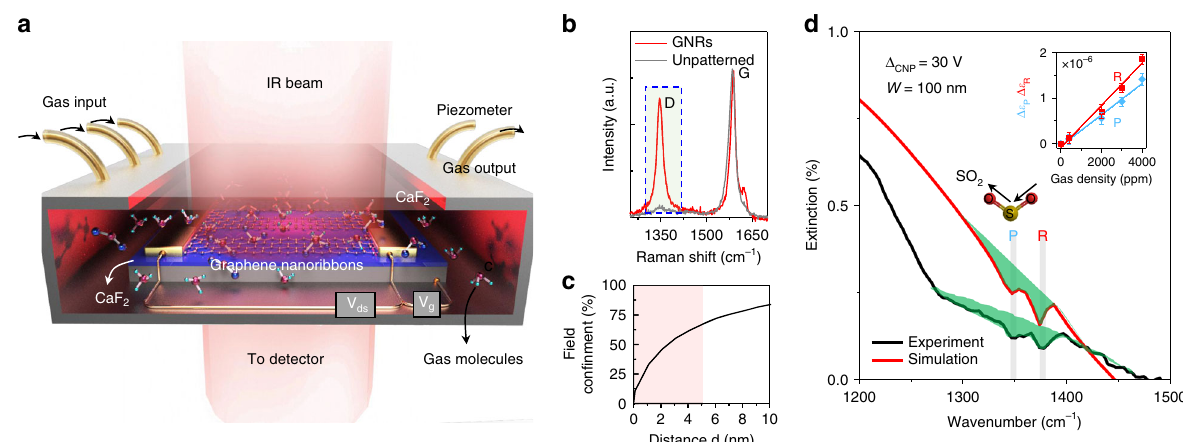
Fig. 1 The graphene plasmon device for gas identi fi cation. a Experimental scheme of our device. A metal chamber with a piezometer was used for precise control of gas parameters. Plasmons in a graphene ribbon array were excited using an incident infrared beam and tuned in situ by electrostatic doping through a gate voltage ( V g ). The plasmon resonances were coupled with molecular excitations, thus probing the rotational – vibrational spectral fi ngerprints of gas molecules. b Raman spectrum of the graphene nanoribbons (GNRs) compared with one of an unpatterned graphene sheet. c Plasmonic fi eld con fi nement of a typical GNR with ribbon width of 70 nm. d Experimental (black curve) and simulated (red curve) extinction spectra of GNRs for SO 2 gas identi fi cation. The molecular responses on the plasmonic peaks are marked with solid green areas. The vertical gray lines indicate the rotational-vibrational modes (P, R) of SO 2 . The schematic of the vibrational mode is indicated with arrows in the central inset. The graphene ribbon width is 100 nm with a fi lling factor of 80%, Δ V CNP of 30 V, and SO 2 of 4000 ppm at 1 atm. The simulation adopts an effective ribbon width of 70 nm and Fermi energy of 0.3 eV to best fi t the experimental spectra. Upper inset: oscillator strength vs concentration for the P and R modes of SO 2 . The differences between experimental and simulated spectra may originate in a narrower ribbon width and lower E F of the fabricated